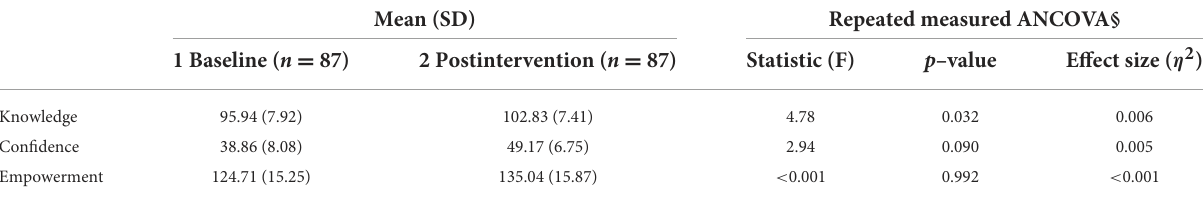
TABLE 4 Caregiver outcomes-baseline, postintervention and follow-up differences.